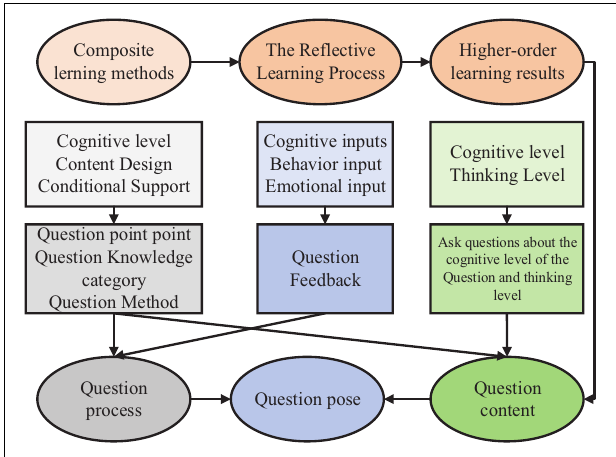
FIGURE 3 | Flowchart of deep learning music